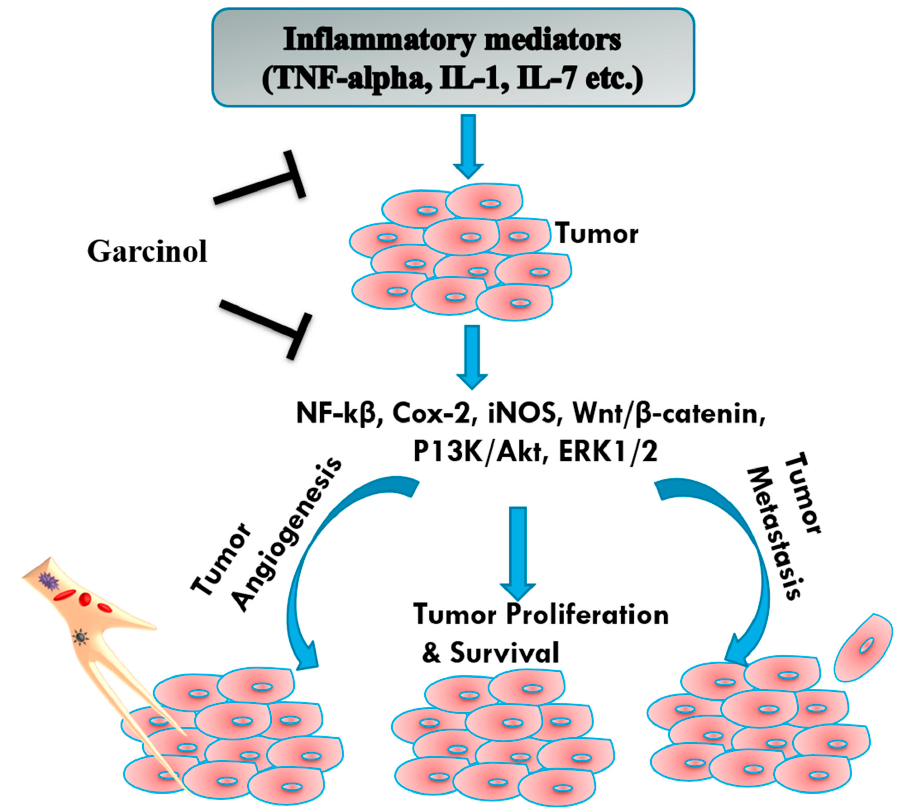
Figure 3. Garcinol mediates anti-inflammatory role in tumor cells via TNF- α , IL-1, and IL-7 which in turn modulates anti-angiogenic and anti-metastatic action in tumor cells is mediated via NF- κ B, Cox-2, iNOS, PI3K/AKT, ERK1/2, and Wnt/ β -catenin signaling pathways. Tumor necrosis factor-alpha (TNF- α ), Interleukin-1 (IL-1), Interleukin-7 (IL-7), Cyclooxygenase-2 (COX-2), inducible nitric oxide